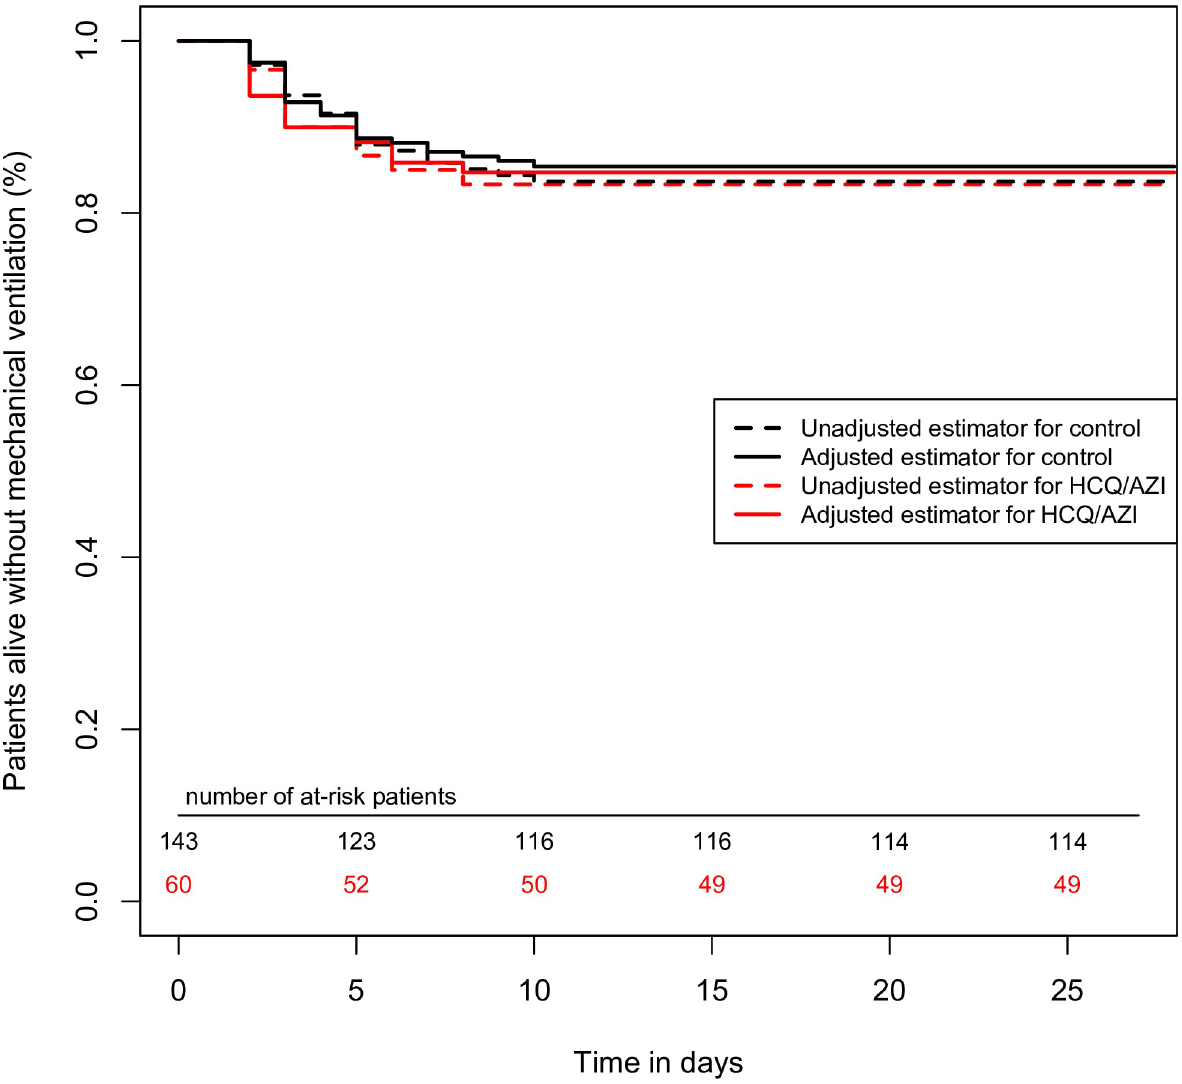
Fig 3. Survival curves, regarding the primary outcome, comparing HCQ/AZI and control group. In the propensity-score matched cohort (n = 203), HCQ/AZI was not associated with the primary outcome (p = 0.16). In the overall cohort (n = 104), there was no association in univariate survival comparison, nor in inverse probability score weighted analysis (p = 0.79 for